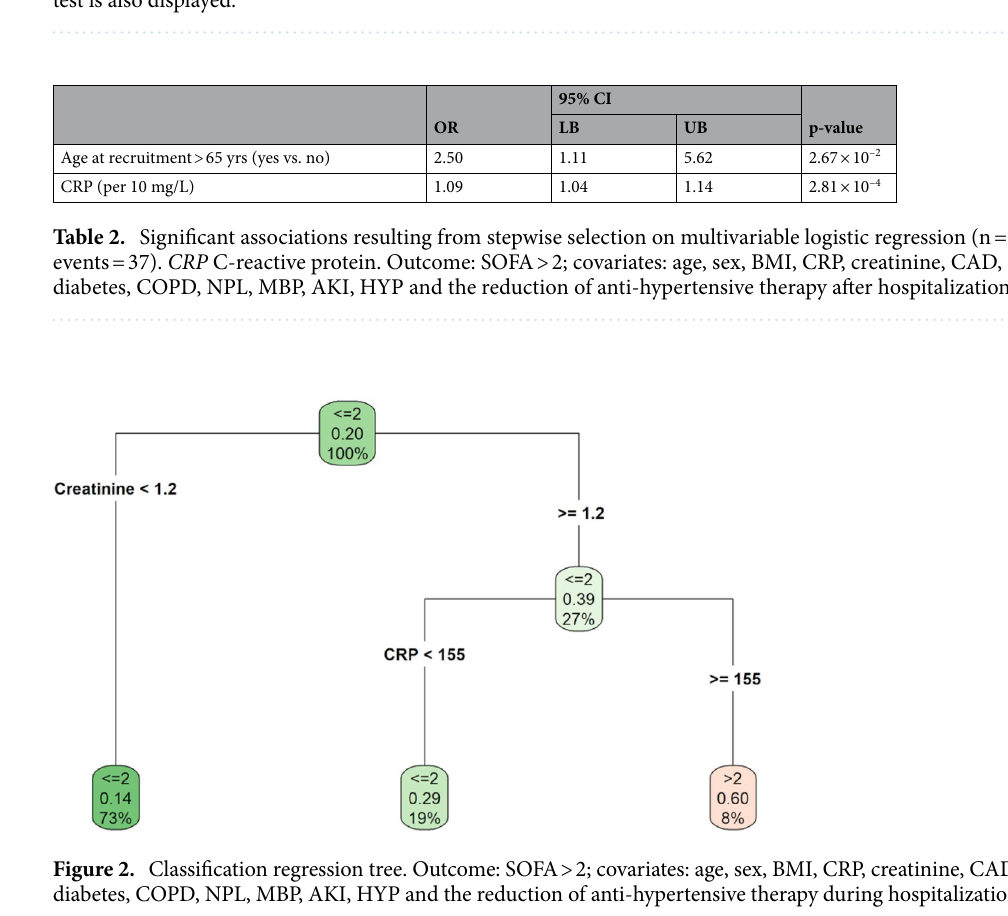
Figure 1. ST analysis and Kaplan–Meier curves and log-rank test. ( A ) ST analysis and ( B ) Kaplan–Meier curves and log-rank test for the three risk groups obtained from the ST analysis based on their HR computed in the final nodes. The low-risk group includes those patients falling in final nodes with an HR lower than 0.5 (n = 139, 36%), patients in the medium-risk group are those with an HR between 0.5 and 1 (n = 139, 36%), and patients in the high-risk groups are those with an HR higher than 1 (n = 110, 28%). The P value associated with the log-rank test is also displayed.